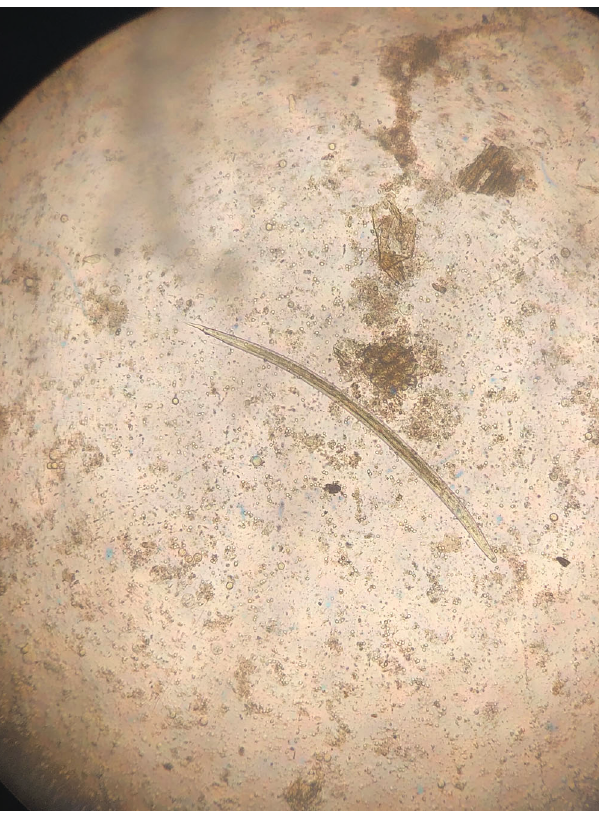
Figure 8: Trichostrongylus sp. (head rounded, short-sized larva, the tail of sheath is short, and bearing one or two tuberosities). Third- stage larvae.